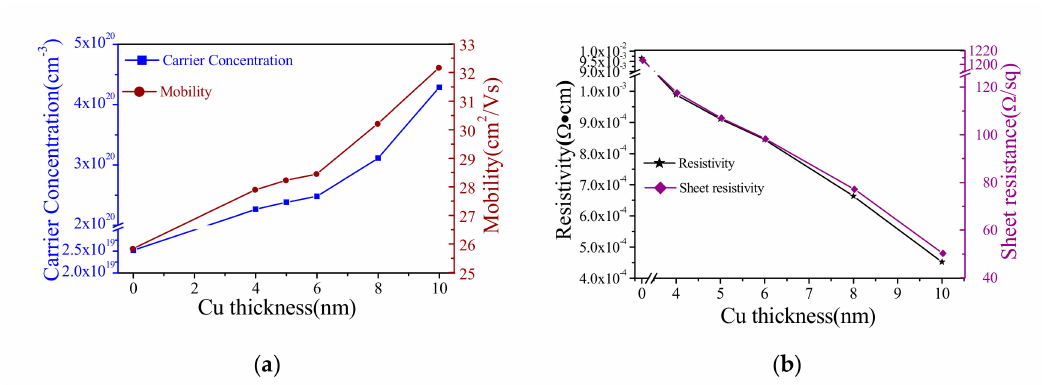
Figure 6. ( a ) Carrier mobility and concentration of IWO / Cu / IWO films with di ff erent Cu layer thicknesses on quartz substrates. ( b ) Resistivity and sheet resistance of bare IWO thin film and IWO / Cu / IWO films with various Cu layer thicknesses on quartz